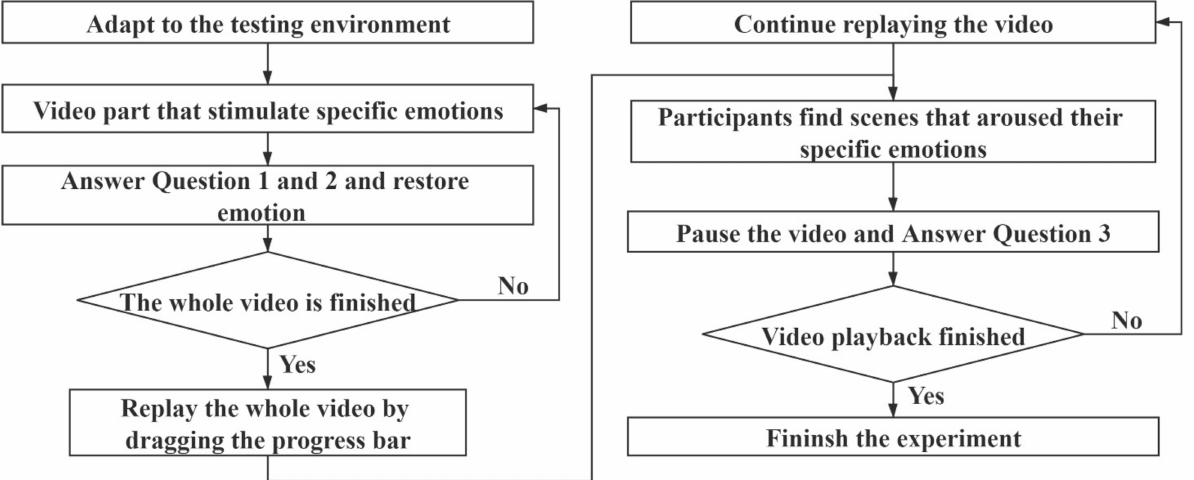
Figure 5. Block diagram of experimental procedures.